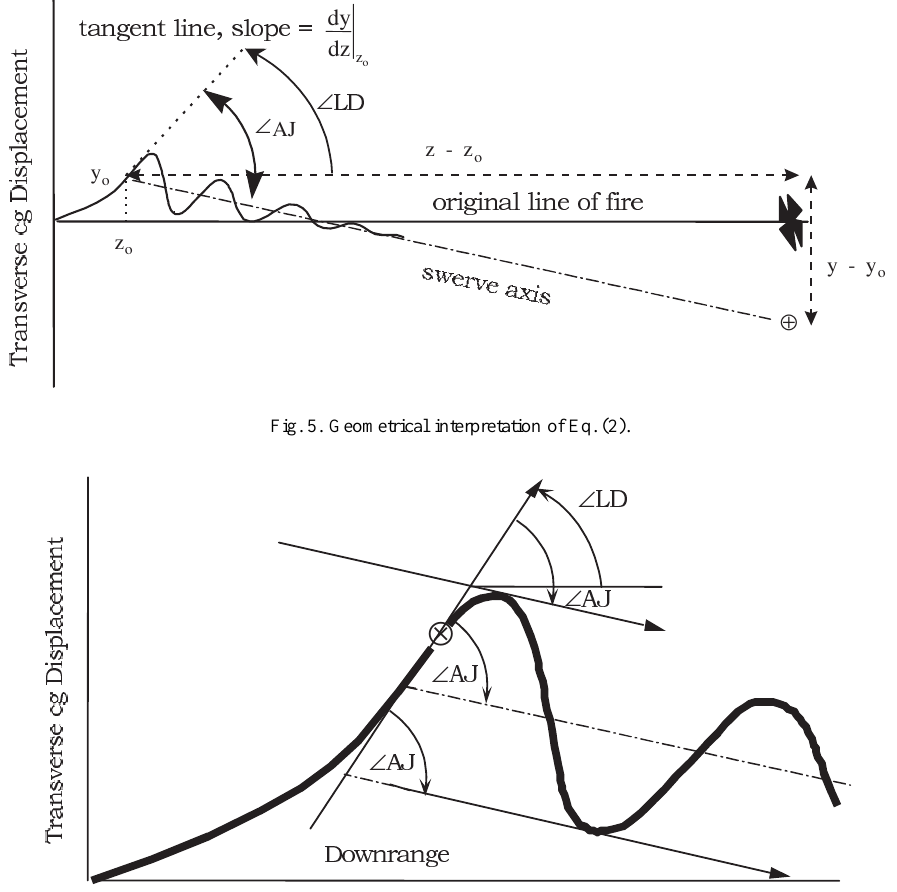
Fig. 6. Alternative geometrical definitions